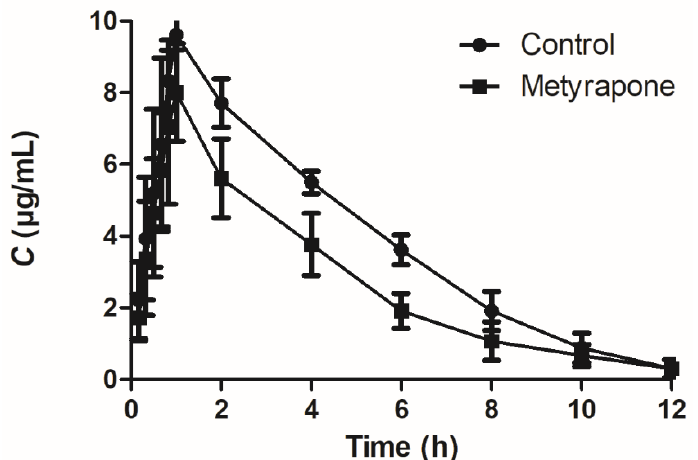
Figure 7. Plasma concentration–time profiles of sulfadiazine after single oral administration at a dose of 20 mg/kg body weight alone and administration 24 h after CXR agonist metyrapone treatment. Data represent means ± SD ( n = 6). Table 1. Pharmacokinetic parameters of orally administered sulfadiazine in chickens.